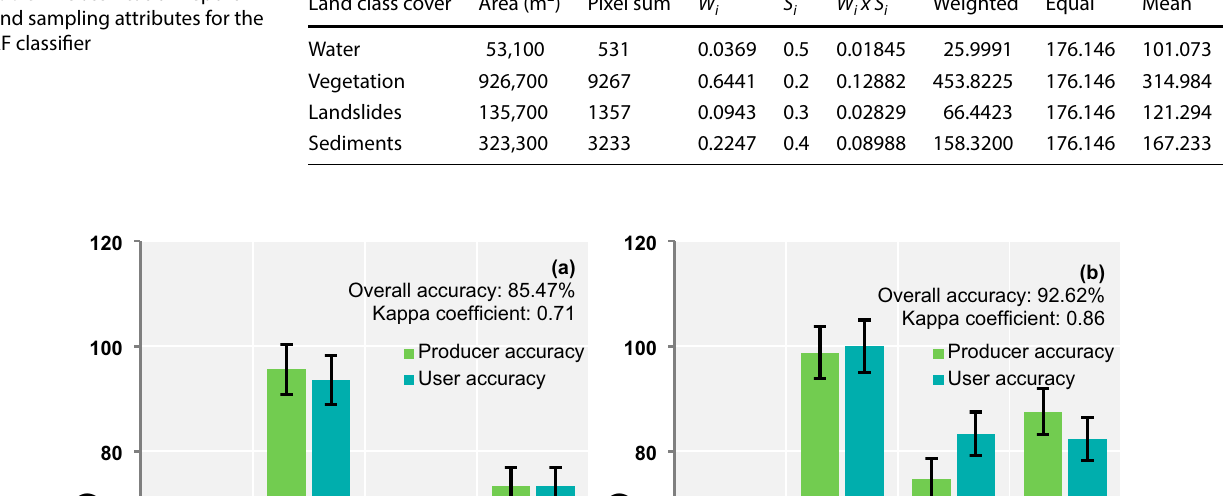
Table 4 Classification report and sampling attributes for the